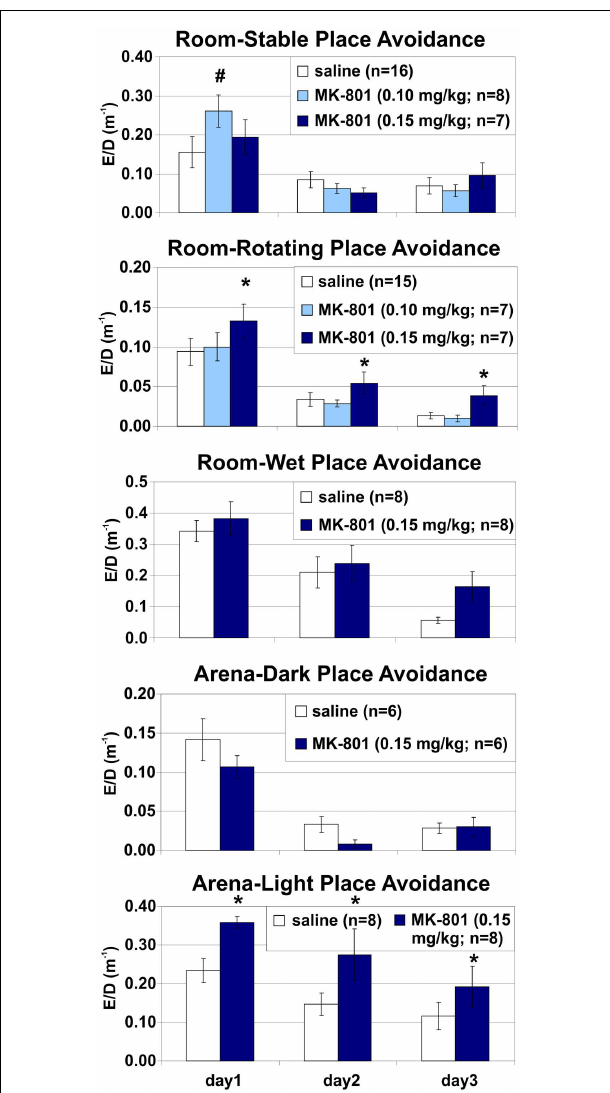
FIGURE 6 | Place avoidance normalized by locomotion in different versions of the place avoidance task . MK-801 (0.15mg/kg) increased the number of entrances per unit distance (ED) in the Room-Rotating and Arena-Light conditions, suggesting that the place avoidance deficit was not due to hyperlocomotion. *Significant effects of treatment; # significant effect of treatment × session interaction.